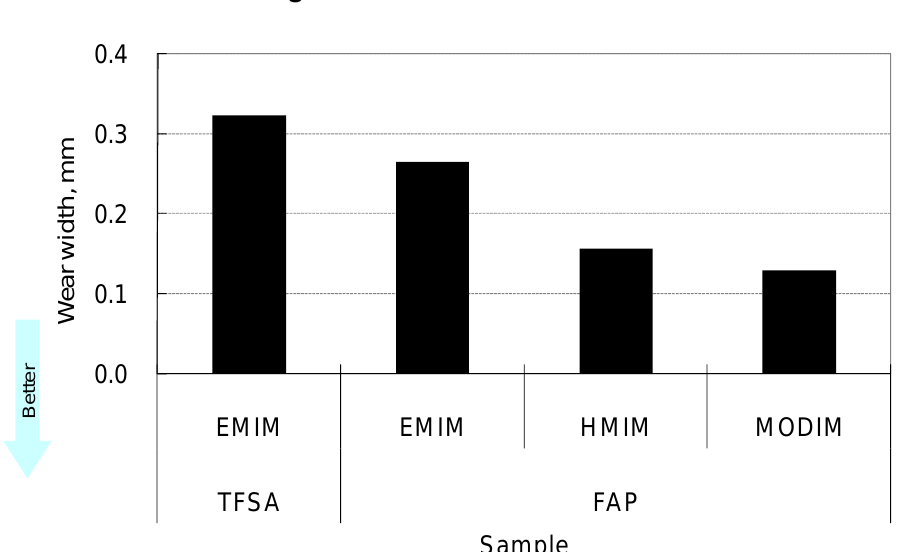
Figure 4. Effect of anion on